Question: Which visualization type does this figure use?
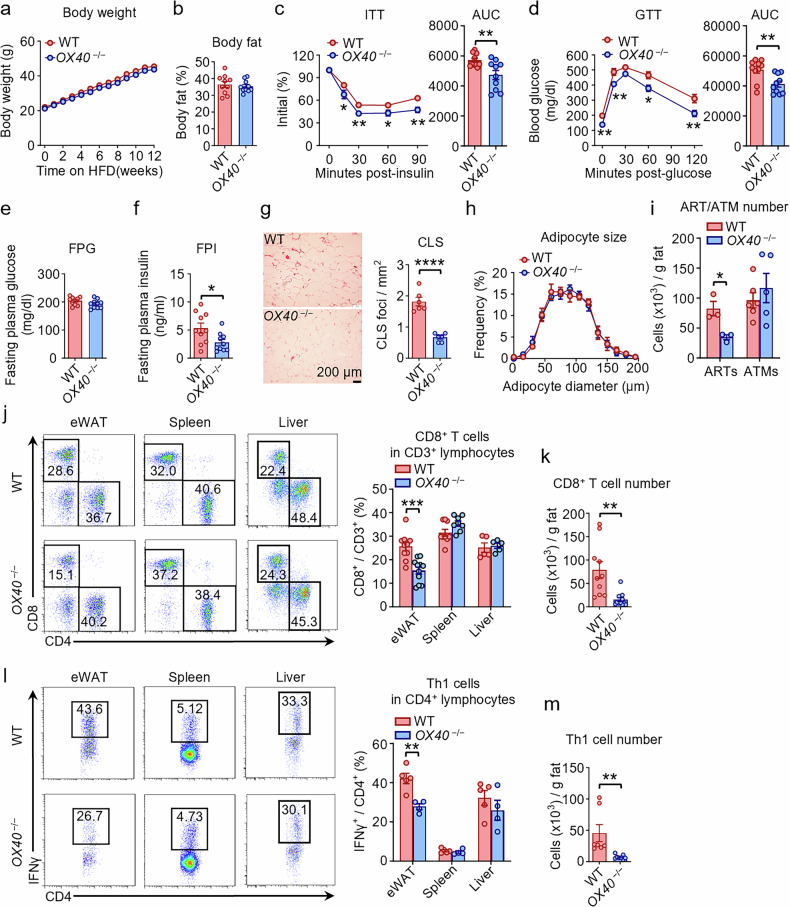
Answer: line